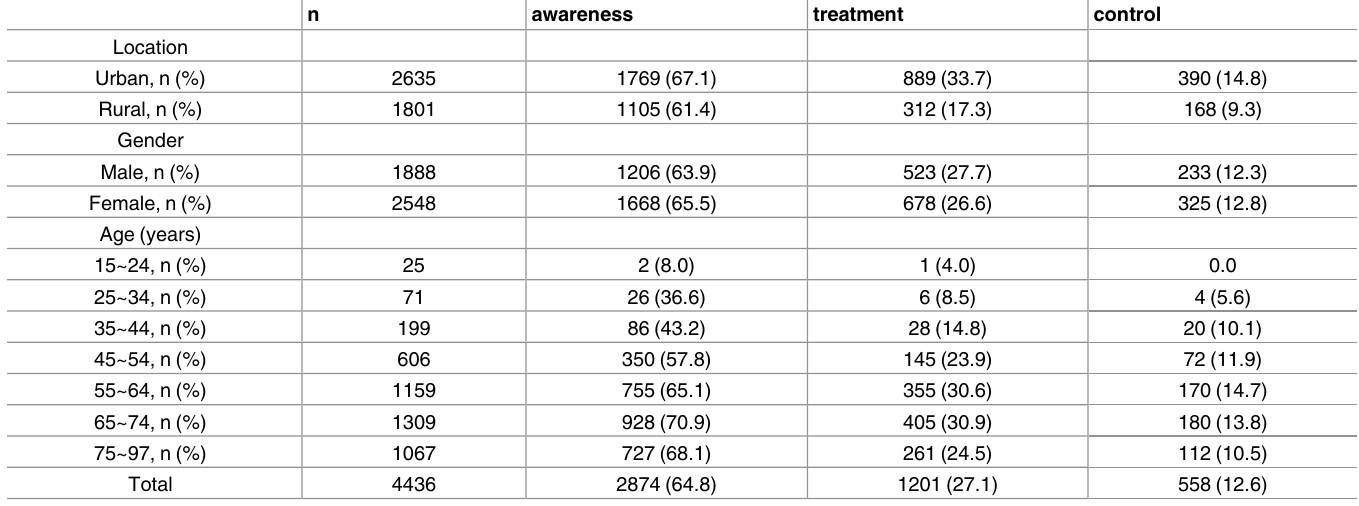
Table 5. Awareness,treatment, and control rates of